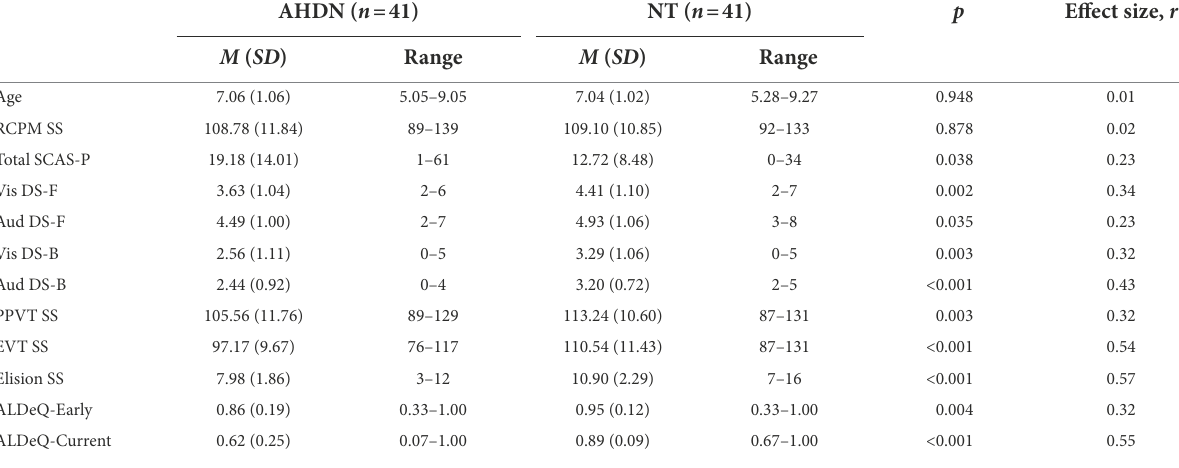
TABLE 1 Descriptive information and Mann–Whitney U test results comparing matched AHDN and NT